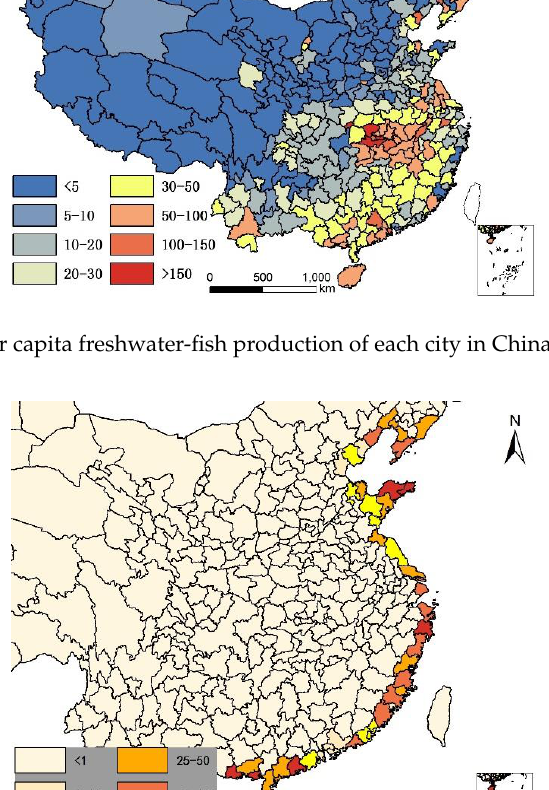
Figure 11. Per capita sea fishing of each city in China in 2016 (kg).